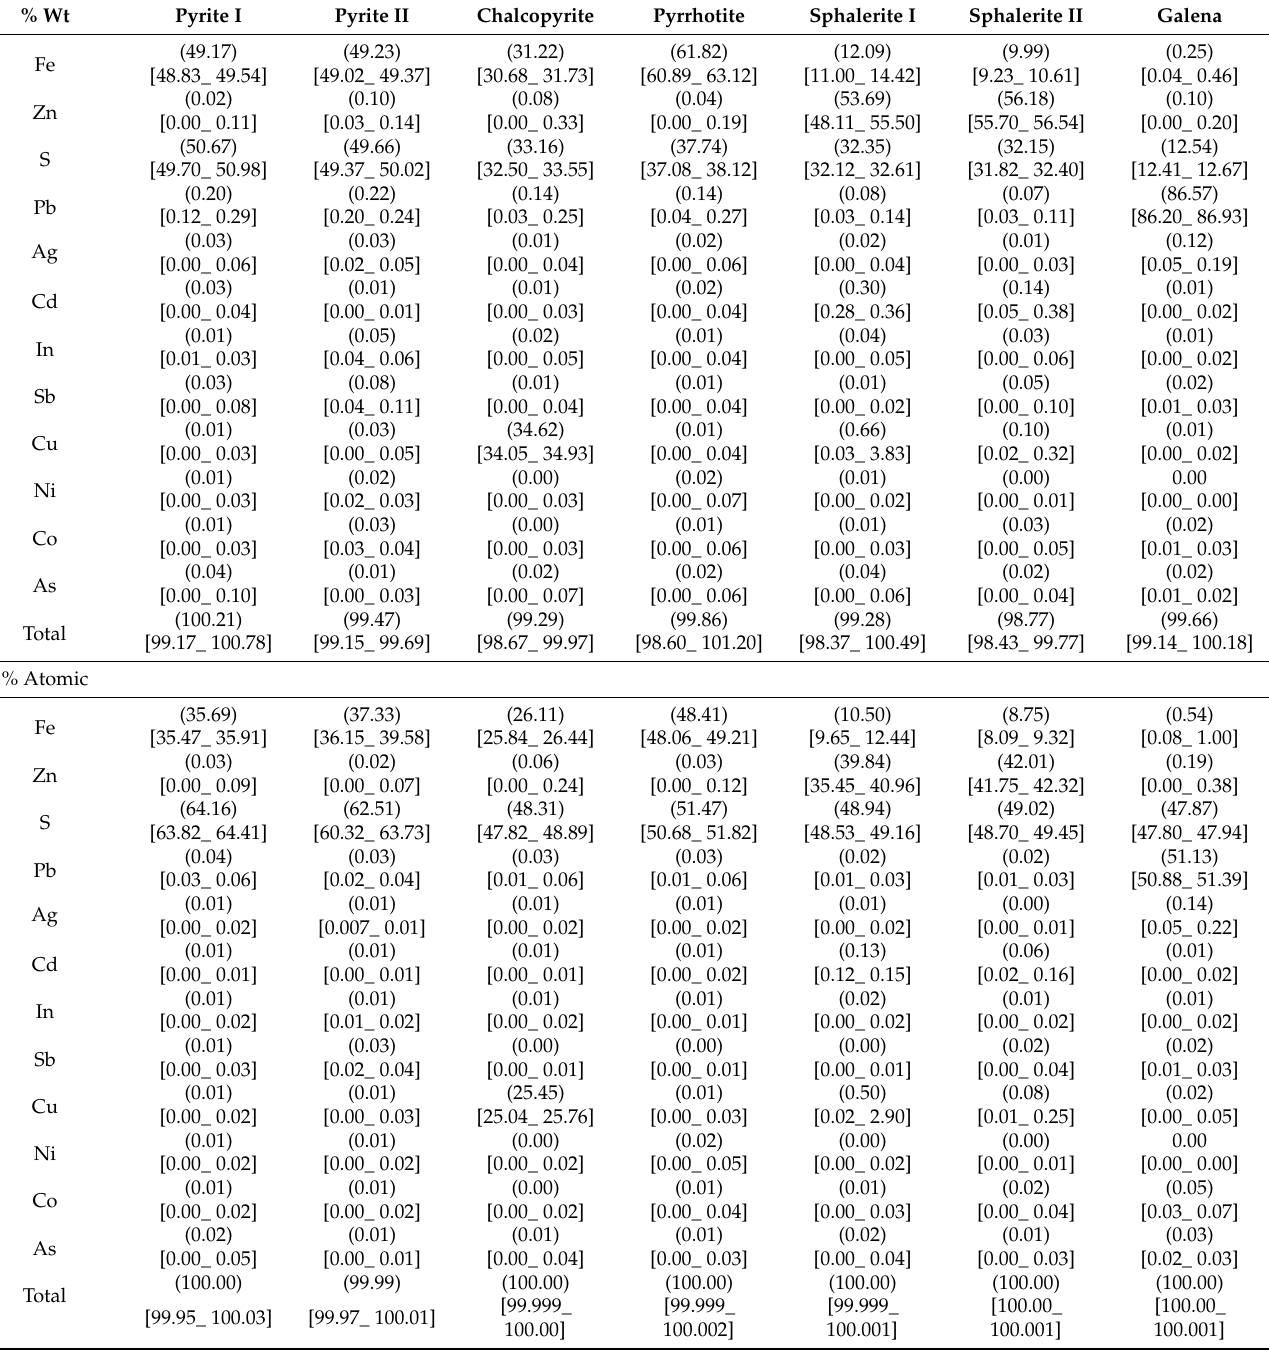
Table 1. Electron microprobe analysis of NNE-A mineral paragenesis. (.): average amounts; [–]: minimum and maximum